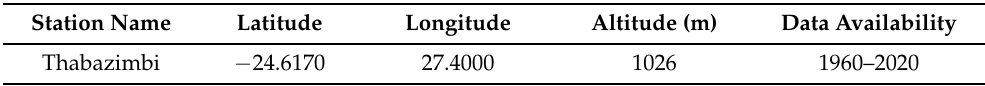
Table 1. Thabazimbi weather station